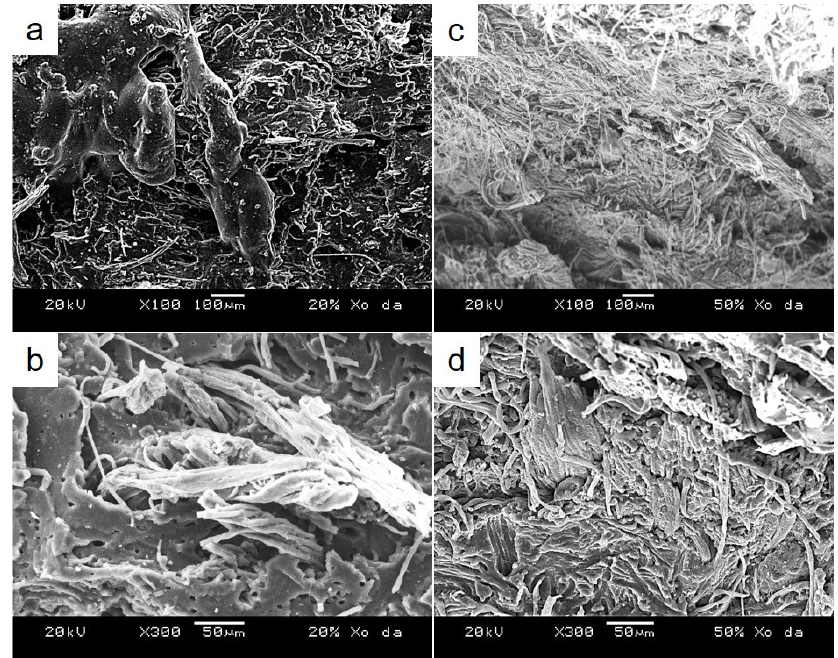
Figure 6. SEM observation of WLF/NBR composite: ( a , b ) 20/80 wt% and ( c , d ) 50/50 w / wt .